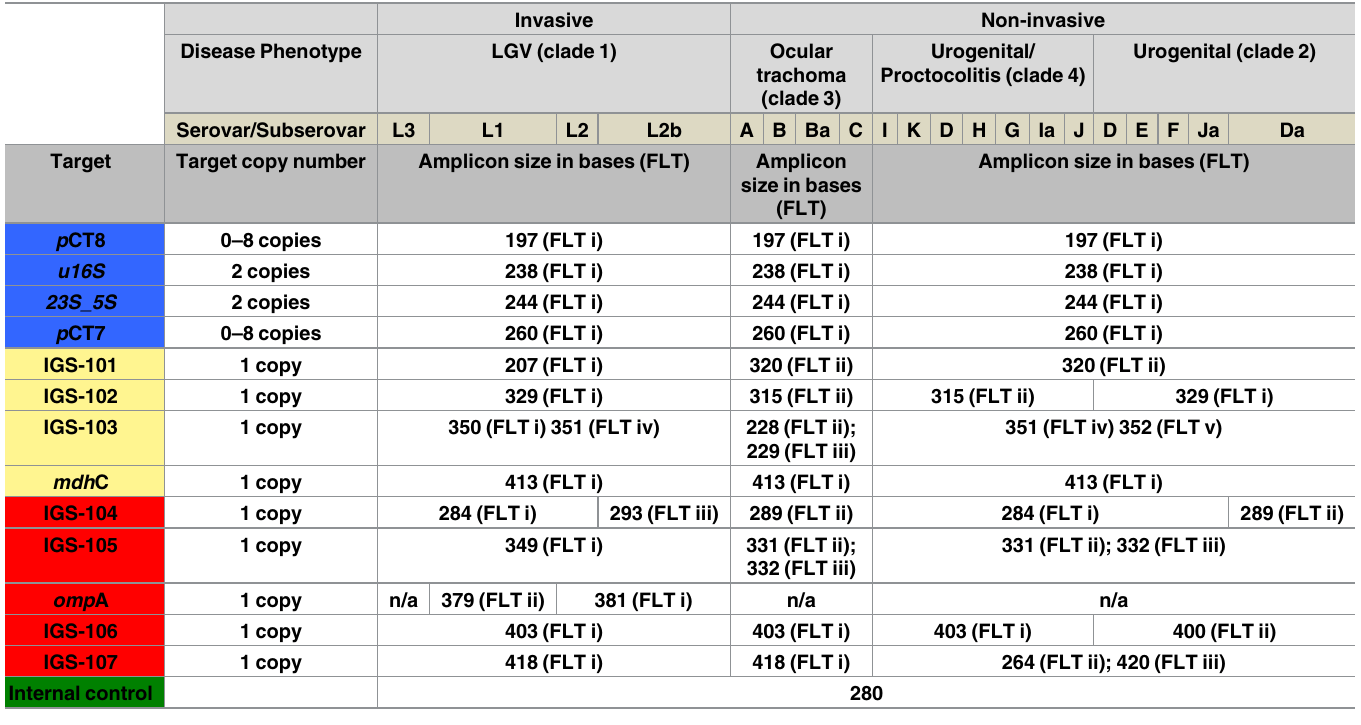
Table 1. Ct amplification targets and their strain types based on expectedand observed amplicon sizes.